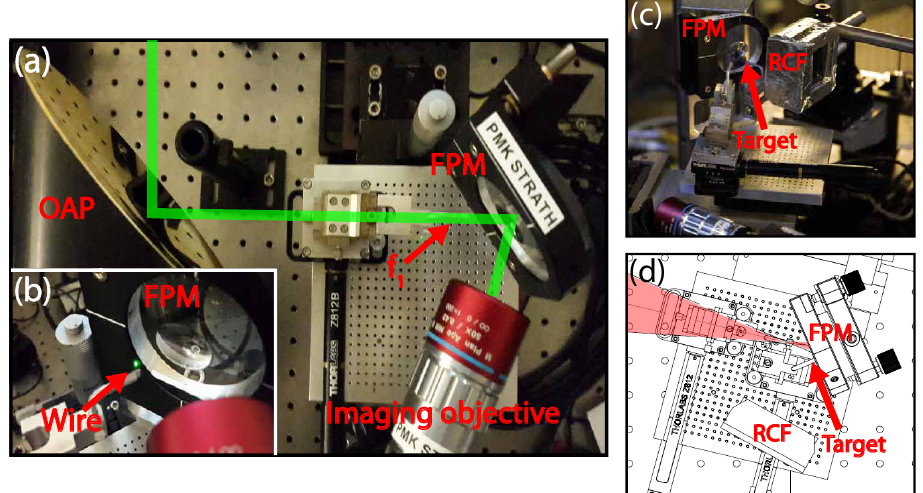
Figure 5. ( a ) Photograph of the set-up used to pre-align an FPM before transferring to the Vulcan-PW vacuum chamber, where a 7 µ m diameter wire was used to define position f 1 . ( b ) Photograph showing the alignment wire at position f 1 , scattering green light from the OAP focus. ( c ) Photograph of the experimental set-up employed to quantify the maximum energy of laser-accelerated protons from a 6 µ m-thick Al target positioned at f 2 and a stack of dosimetry radio-chromic film (RCF). ( d ) Equivalent schematic